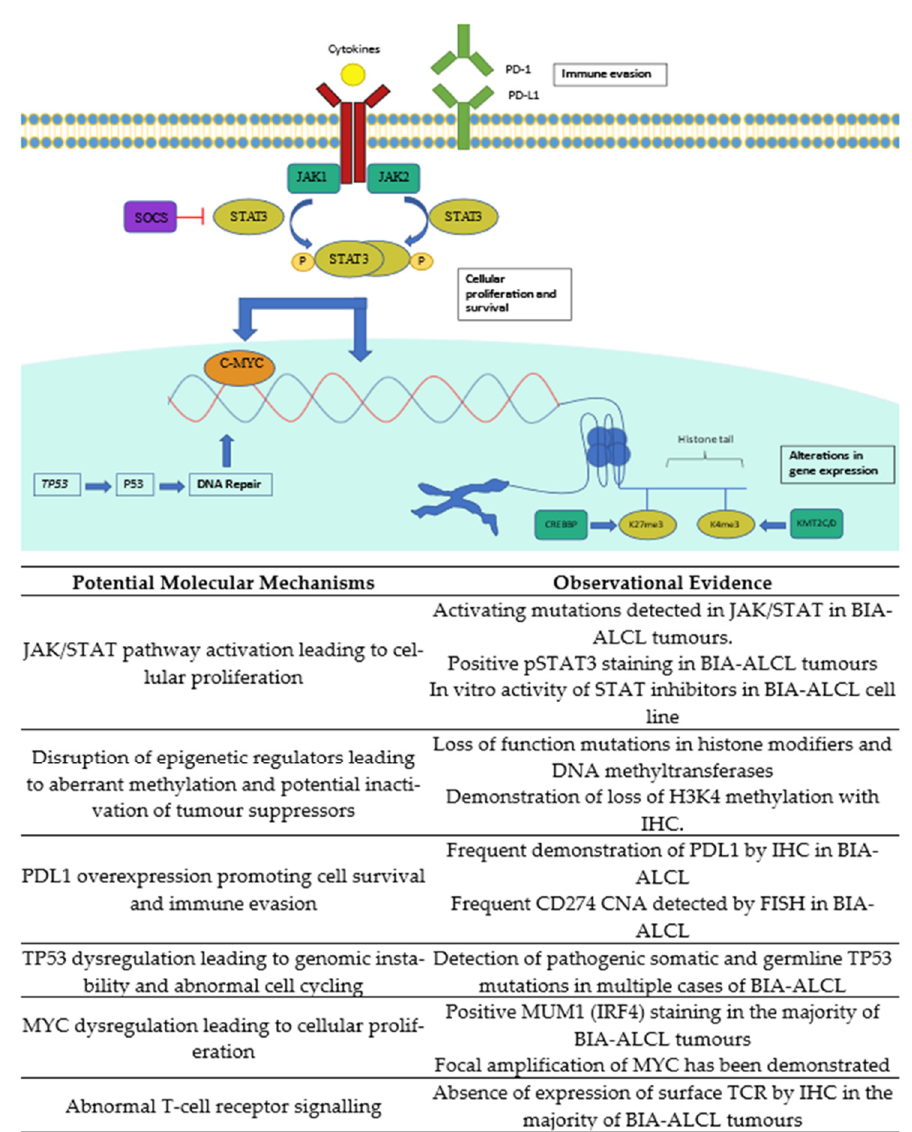
Figure 1. Summary of the molecular pathways potentially contributing to lymphogenesis.